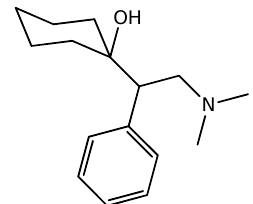
Figure 29. Venlafaxine.